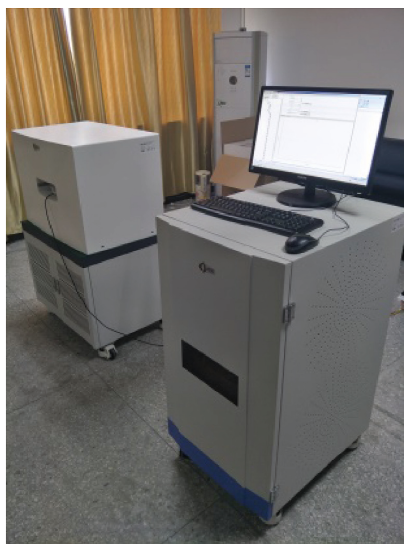
Figure 1: NMR analyzer.